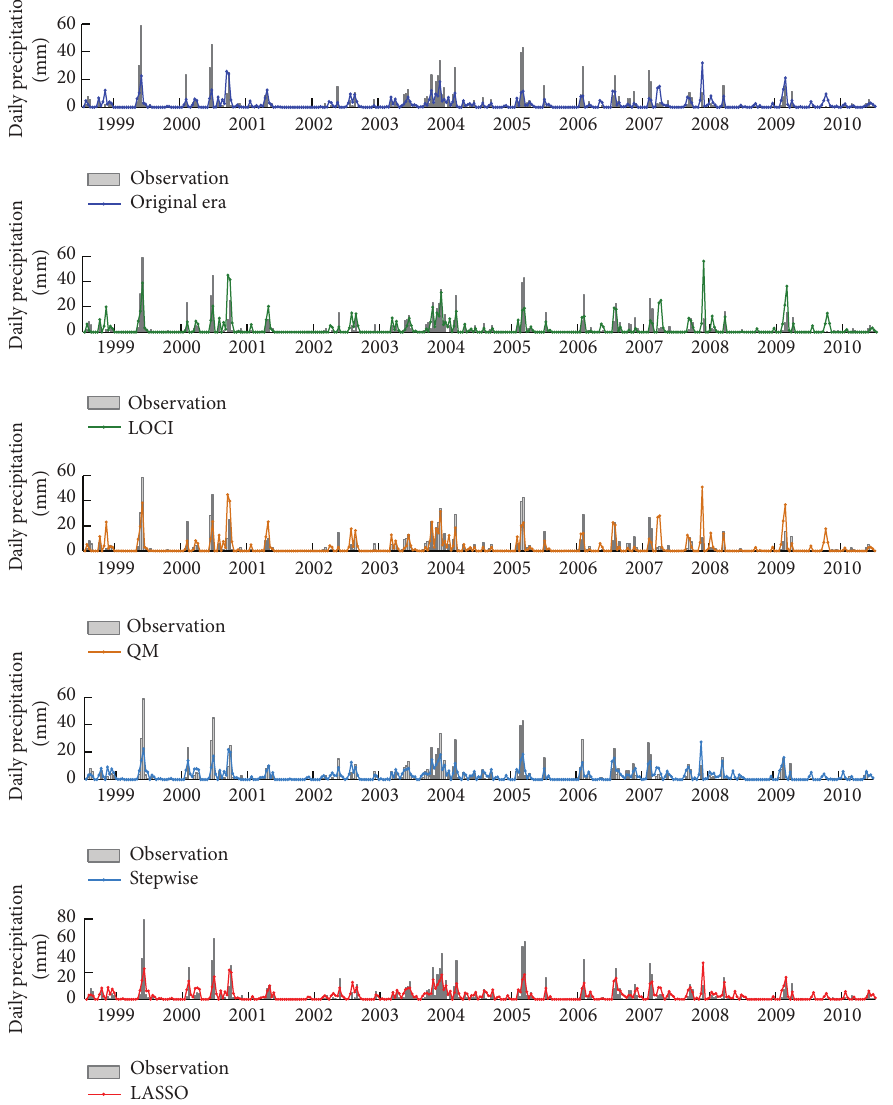
Figure 5: Comparison of observations with downscaled daily precipitation for the four downscaling methods, as well as the original ERA- Interim data in January at station WFJ during the validation period